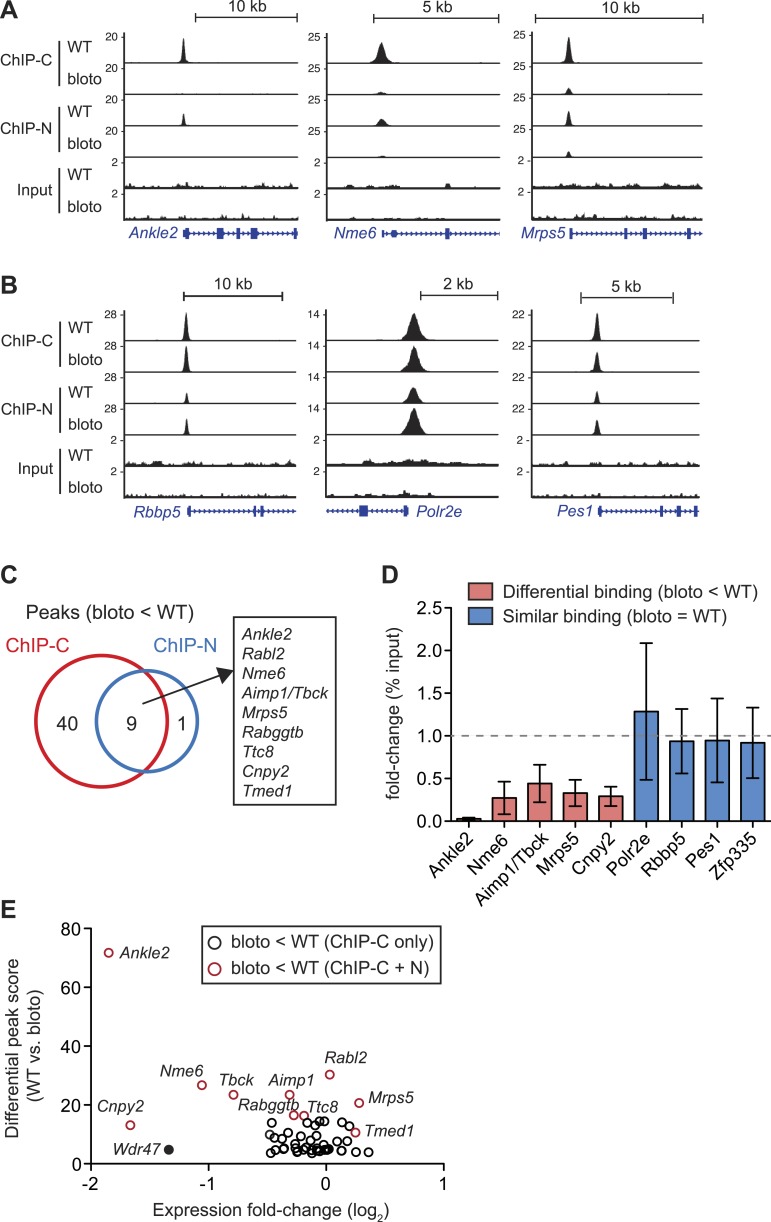
Decreased Zfp335 binding in blt/blt thymocytes is detected for a
subset of target genes.(A) Signal tracks showing Zfp335 occupancy at three target
genes (Ankle2, Nme6, Mrps5) for which significantly
decreased binding in blt/blt relative
to WT thymocytes is observed using both the C-terminus-specific antibody
(ChIP-C) and the N-terminus-specific antibody (ChIP-N). Vertical axis,
fragment pileup per million reads (normalized to library sequencing
depth). Input, sequencing of input genomic DNA (background control).
(B) Signal tracks showing Zfp335 occupancy at three
target genes (Rbbp5, Polr2e, Pes1) for which no
reduction in binding is detected in
blt/blt thymocytes. (C)
Identification of nine putative differentially bound target sites and
their ten associated genes from the intersection of differential peaks
(bloto < WT) called for both ChIP-C and ChIP-N data sets. We consider
Aimp1 and Tbck to be associated with
a single peak as they share a bidirectional promoter. (D)
ChIP-qPCR analysis of Zfp335 binding at selected targets to validate
ChIP-seq-based assessment of differential binding in
blt/blt thymocytes. ChIP enrichment
was calculated as percent input; results are presented as the fold-change
in ChIP enrichment for blt/blt vs WT (mean ± s.d.,
n = 3 for three independent experiments).
(E) Relative Zfp335 binding and gene expression changes
for target genes associated with the ChIP-C set of differentially bound
regions: horizontal axis, expression fold-change (log2) values
from microarray analysis of blt/blt vs WT mature CD4SP
thymocytes; vertical axis, score reflecting likelihood that Zfp335
binding is significantly enriched in WT relative to
blt/blt thymocytes. Red circles, target genes
identified as differentially bound in both ChIP-C and ChIP-N data sets
(Figure 6C); black circles,
target genes associated with reduced Zfp335 binding in the ChIP-C but not
ChIP-N data set. Wdr47 is highlighted (filled black
circle) as a target gene that was identified as differentially bound only
in the ChIP-C data set (Figure 6—figure
supplement 1C,D) but showed significantly downregulated
expression in blt/blt thymocytes (Figure 6—figure supplement 1B,E).